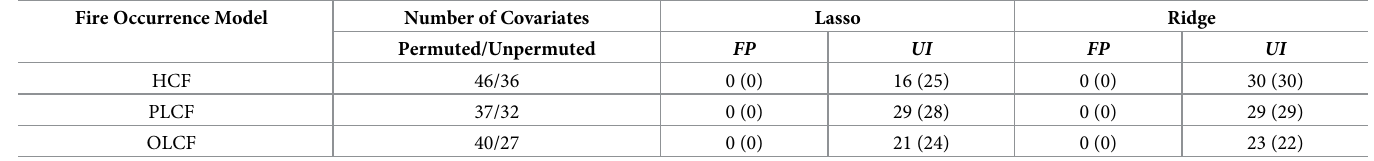
Table 7. Case study. Number of permuted and unpermuted covariates, number of permuted covariates classified as important (false positives, FP ), and number of unper- muted covariates classified as important ( UI ). FP and UI values outside and inside the parentheses correspond to λ 1 se and λ min , respectively. The results are based on M = 500 balanced